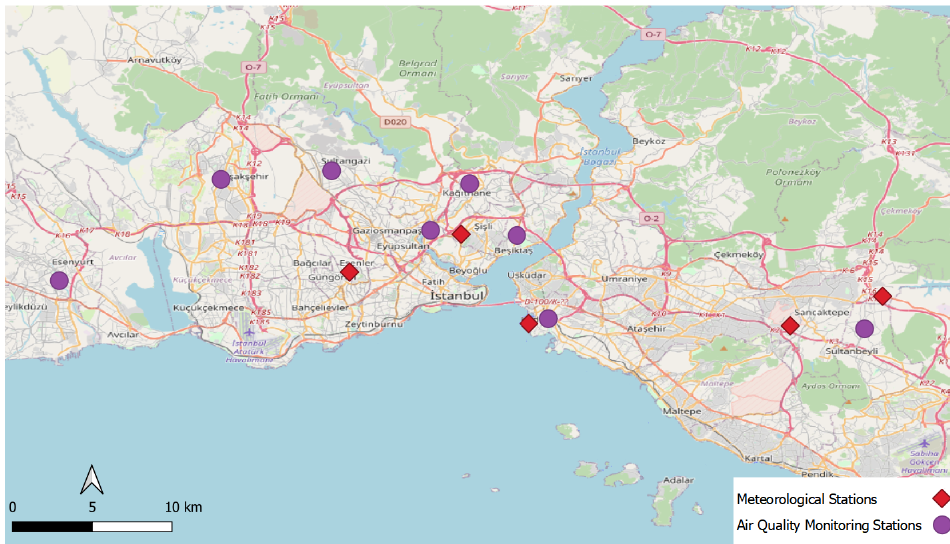
Figure 1. Location of meteorological and air quality monitoring stations. Table 1. Statistical summary of the air quality monitoring stations’